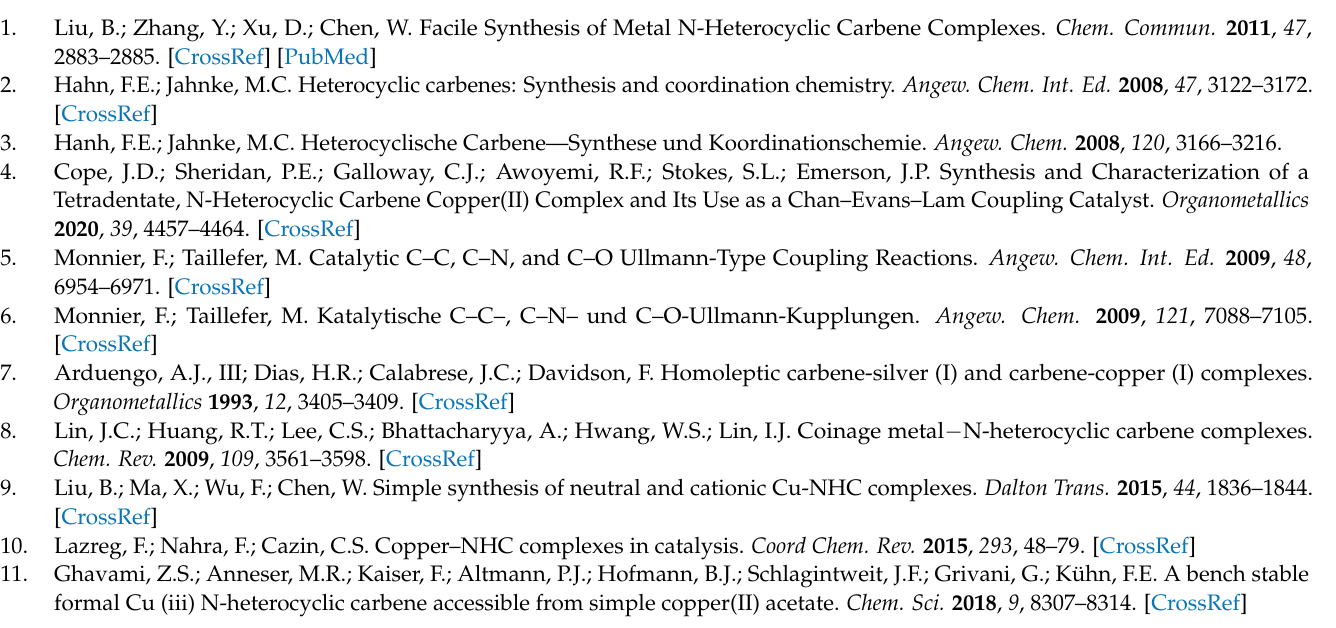
Figure S2: 13 C NMR of complex 1 ; Figure S3: 1 H NMR of complex 2 ; Figure S4: 13 C NMR of complex 2 ; Figure S5: HR-MS of complex 3 in CH 3 CN solution (TNHC2 = tridentate ligand 2 moi- ety); Figure S6a: Crystal views of complex 3 ; Figure S6b: Figure showing the asymmetric unit of complex 3 ; Figure S6c: Pictures of the measured crystal: platelet with the following dimen- sions: (0.080 × 0.142 × 0.182) mm 3 ; Figure S6d: Diffraction Pattern Frames: Showing no signifi- cant diffracted in-tensity above 1.3 Å of resolution, using a monochromatized Cu X-ray radiation; Figure S7a: Complex 3 powder XRD pattern (measured); Figure S7b: Complex 3 powder XRD pattern (simulated); Figure S7c: Compound 2 powder XRD pattern (measured); Figure S8: FT-IR spectra of (A) compound 1 (B) compound 2 (c) complex 3 (D) comparison of compound 2 (black) and complex 3 (red); Table S1a: Sample and crystal data for complex 3 ; Table S1b: Data collection and structure refinement for complex 3 ; Table S1c: Atomic coordinates and equivalent isotropic atomic dis-placement parameters (Å 2 ) for complex 3 ; Table S1d: Bond lengths (Å) for complex 3 ; Table S1e: Bond angles ( ◦ ) for complex 3 ; Table S1f: Torsion angles ( ◦ ) for complex 3 .; Table S1g: Anisotropic atomic displacement parameters (Å 2 ) for complex 3 ; Table S1h: Hydrogen atomic coordinates and isotropic atomic displacement parameters (Å 2 ) for complex 3 ; Table S1i: Selected bond lengths (Å) bond angles ( ◦ ) for complex 3 ; Table S2: Table showing 2theta values for complex 3 powder XRD (measured and